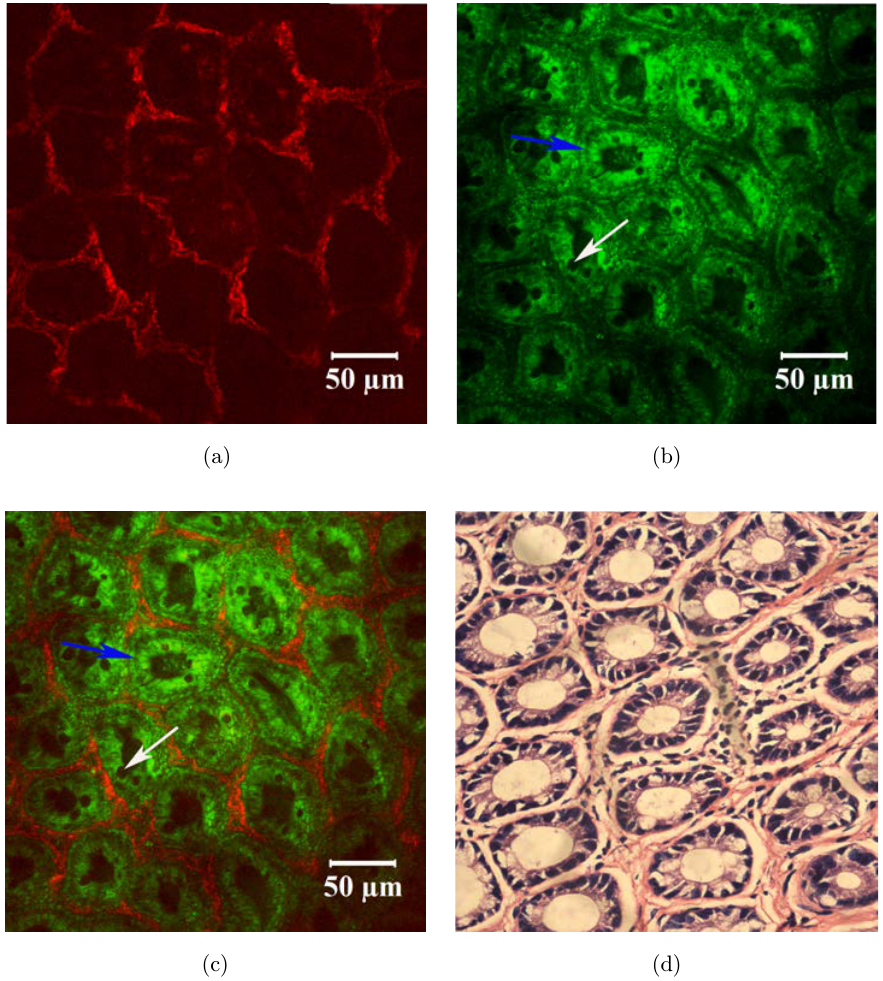
Fig. 2. Images of colomic mucosa. (a) SHG image of collagen, (b) TPEF image of cells, (c) overlayed SHG/TPEF image, and (d) the corresponding H&E image (40 (cid:2) ) showing a similar arrangement compared to the overlayed SHG/TPEF image. Scale bar is 50 (cid:1) m. The blue and white arrows indicate the columnar and mucous cells,